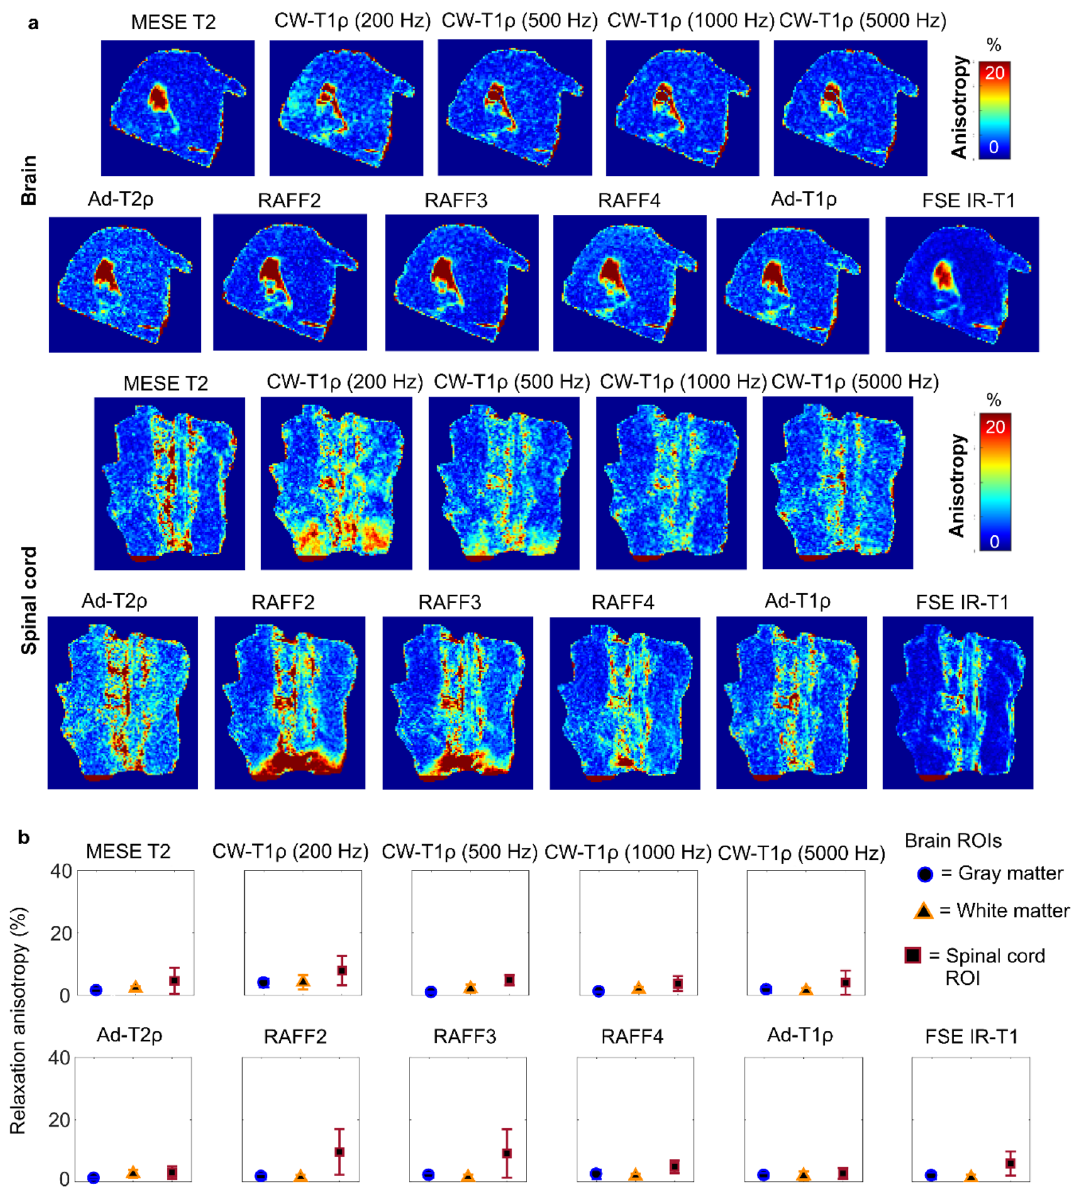
Figure 4. ( a ) Relaxation anisotropy maps of quantitative MRI parameters in brain and spinal cord samples. ( b ) Average relaxation anisotropy in the ROIs defined as shown in Fig.